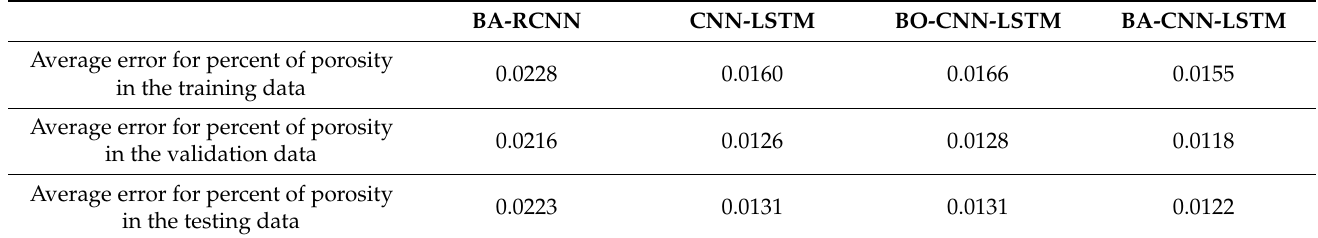
Table 5. The average error for percent of porosity (artificial porosity images).